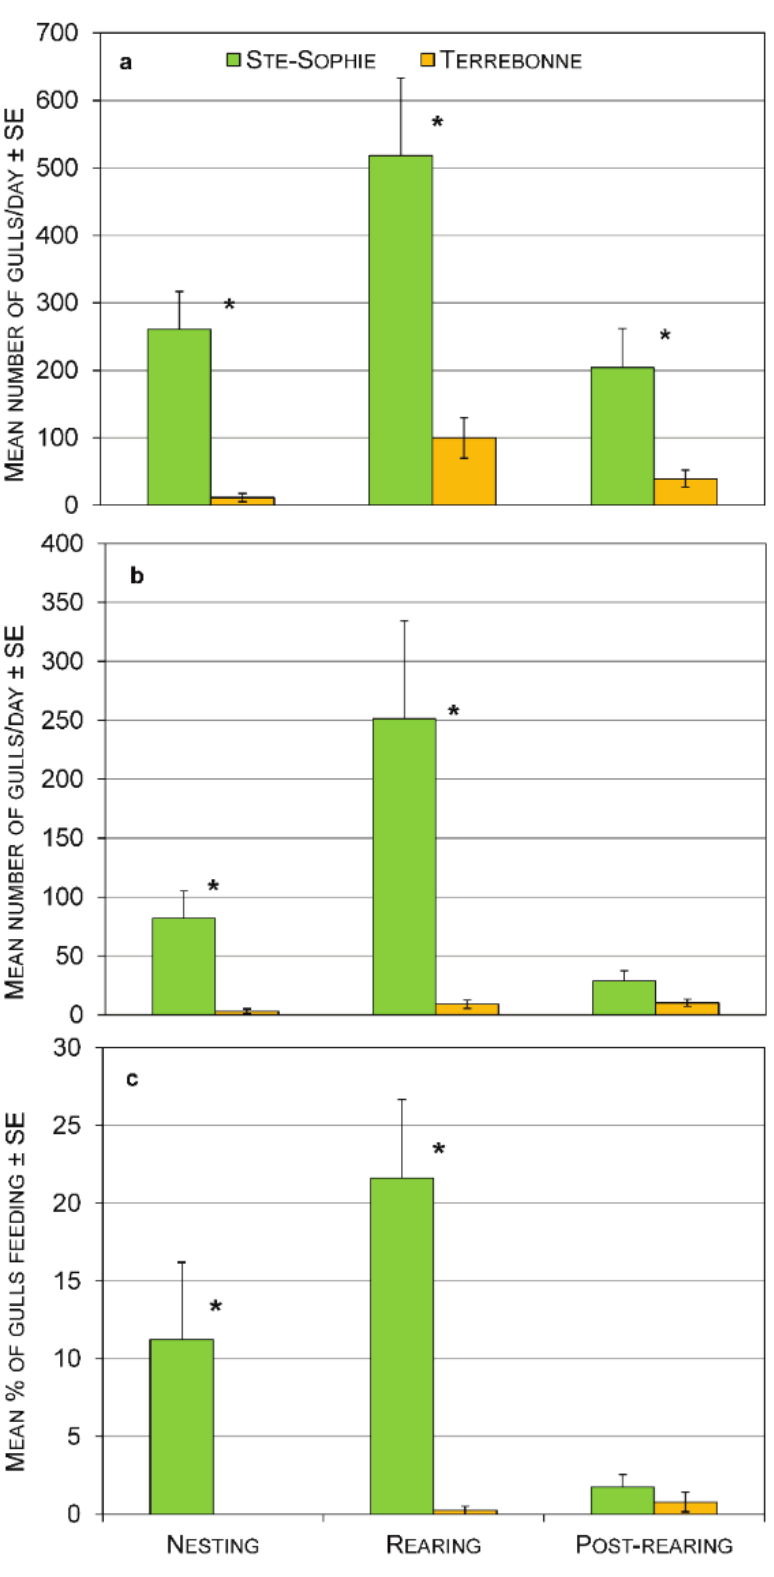
Figure 2. Use of the Terrebonne and Ste-Sophie landfills during the nesting, rearing, and post-rearing stages of ring-billed gulls breeding on Deslauriers Island, QC, 2010: ( a ) Mean ± SE number of gulls/day at each site; ( b ) Mean ± SE number of gulls/day at the tipping area at each site; ( c ) Mean ± SE percent of gulls feeding at each site. Asterisks represent significant differences between sites ( p <